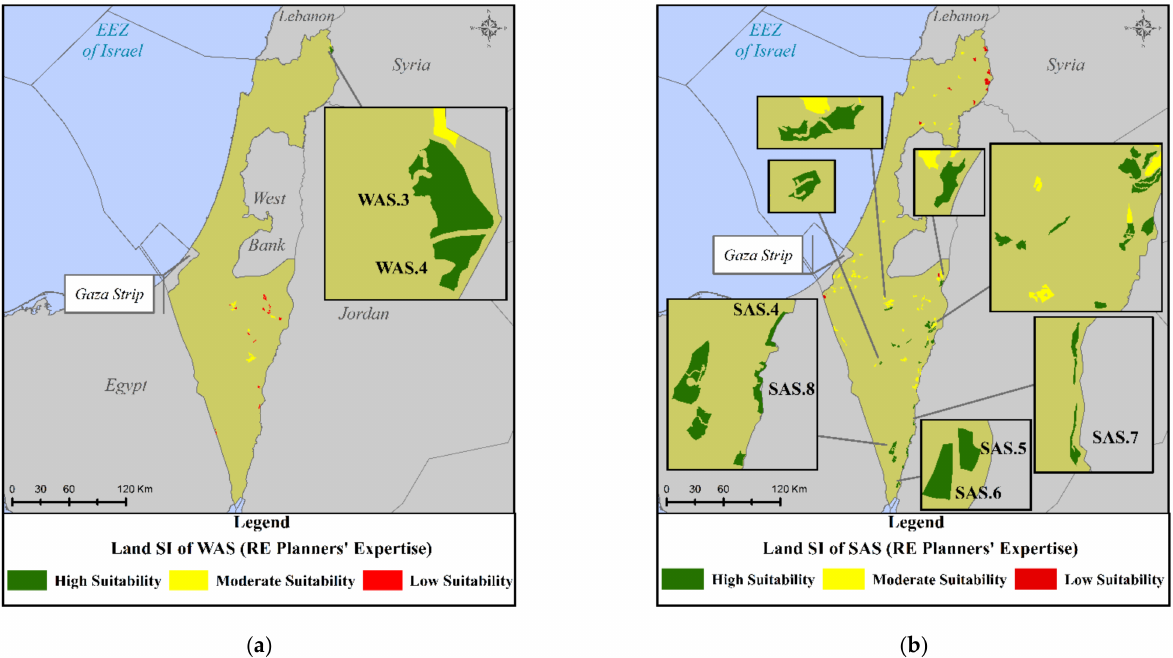
Figure 12. Suitability Index (SI) spatial allocation based on Renewable Energy Planners (REPs) for ( a ) Wind Appropriate Sites (WAS) and ( b ) Solar Appropriate Sites